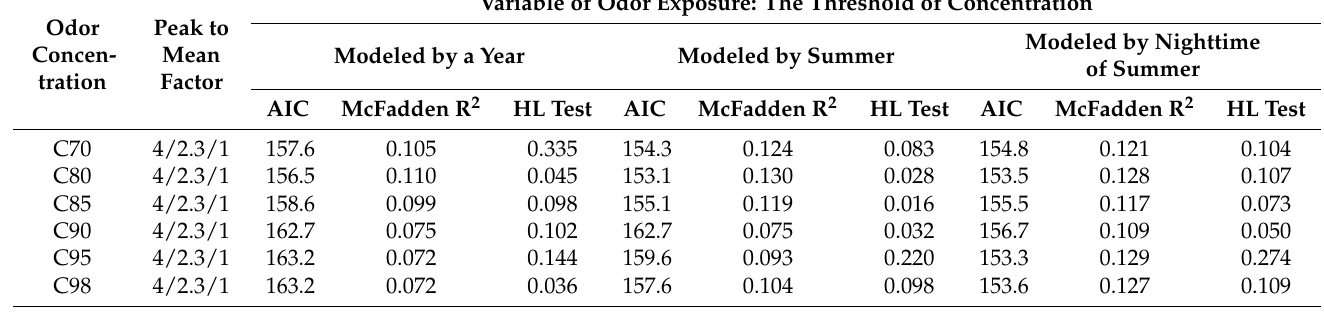
Table 3. Goodness of fit (AIC, McFadden R 2 , HL test) for odor annoyance by binomial logistic regression models a .